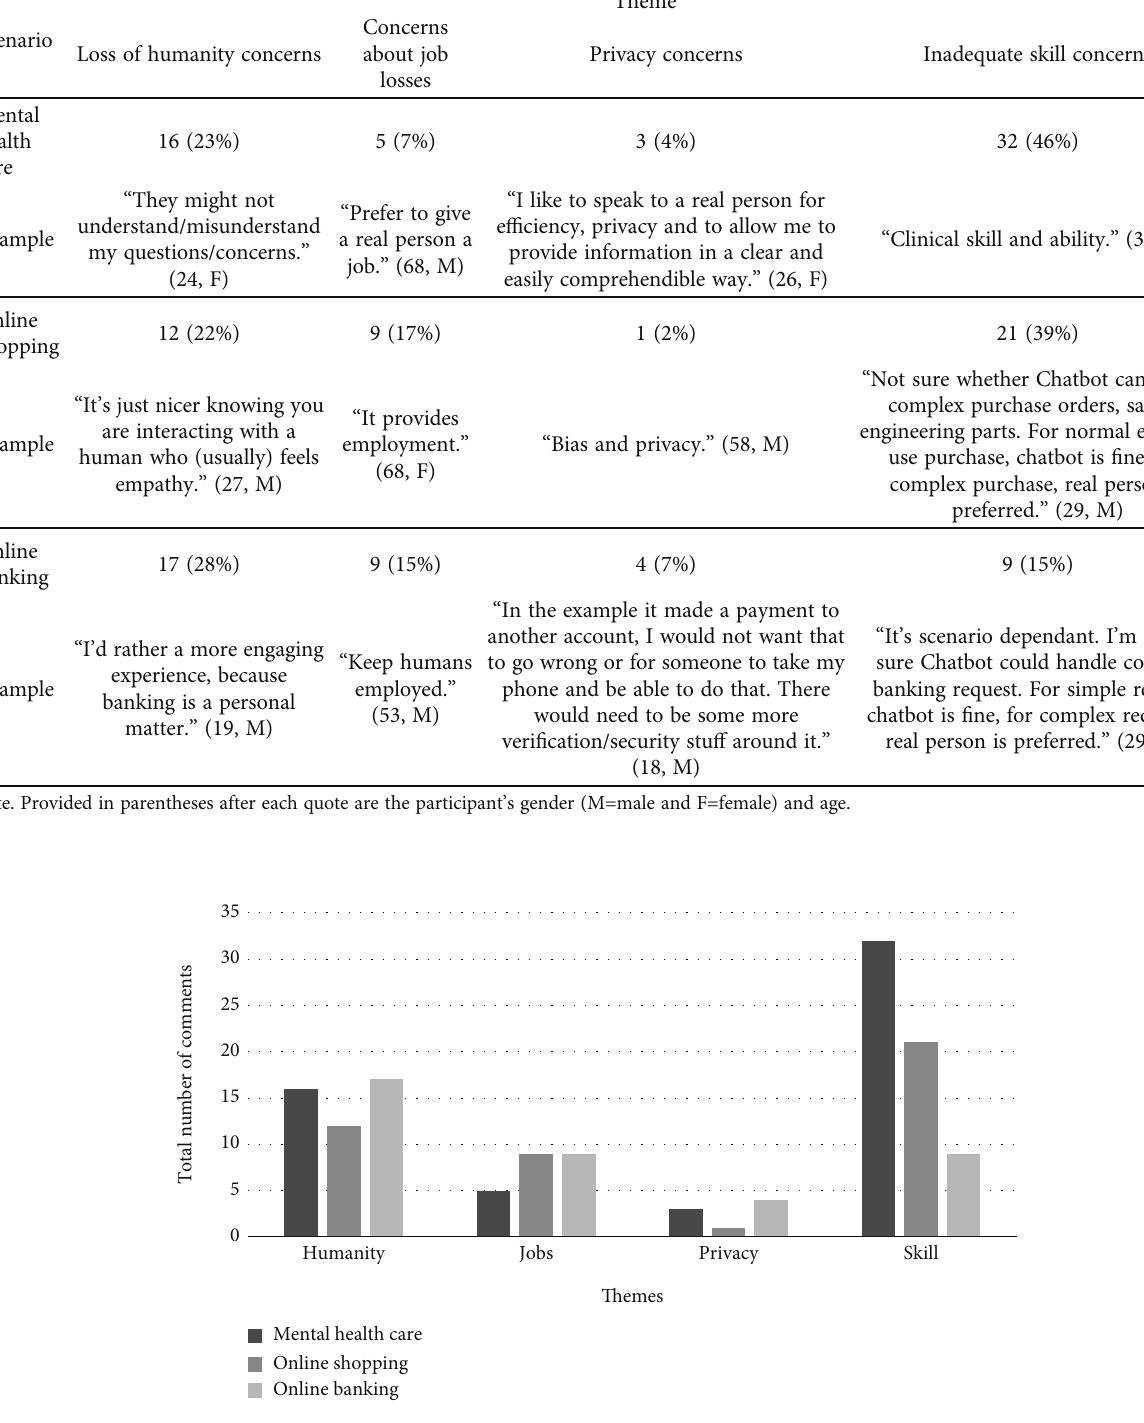
Figure 3: Frequency of